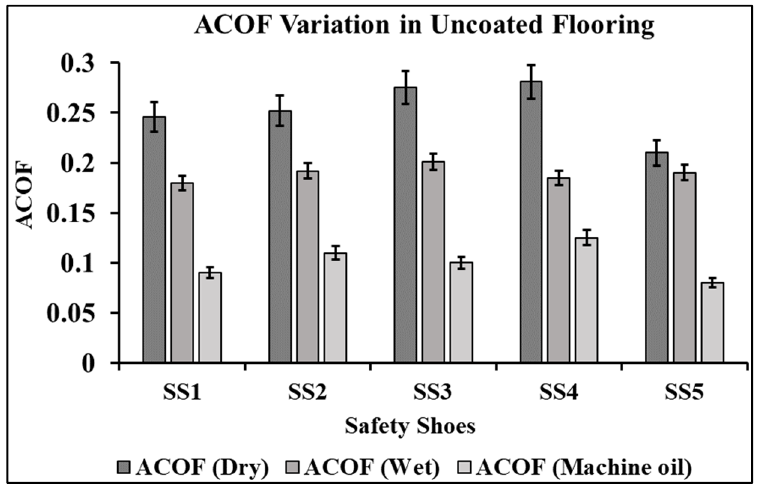
Figure 4. ACOF variation in uncoated laminate flooring across dry, wet, and machine oil slip